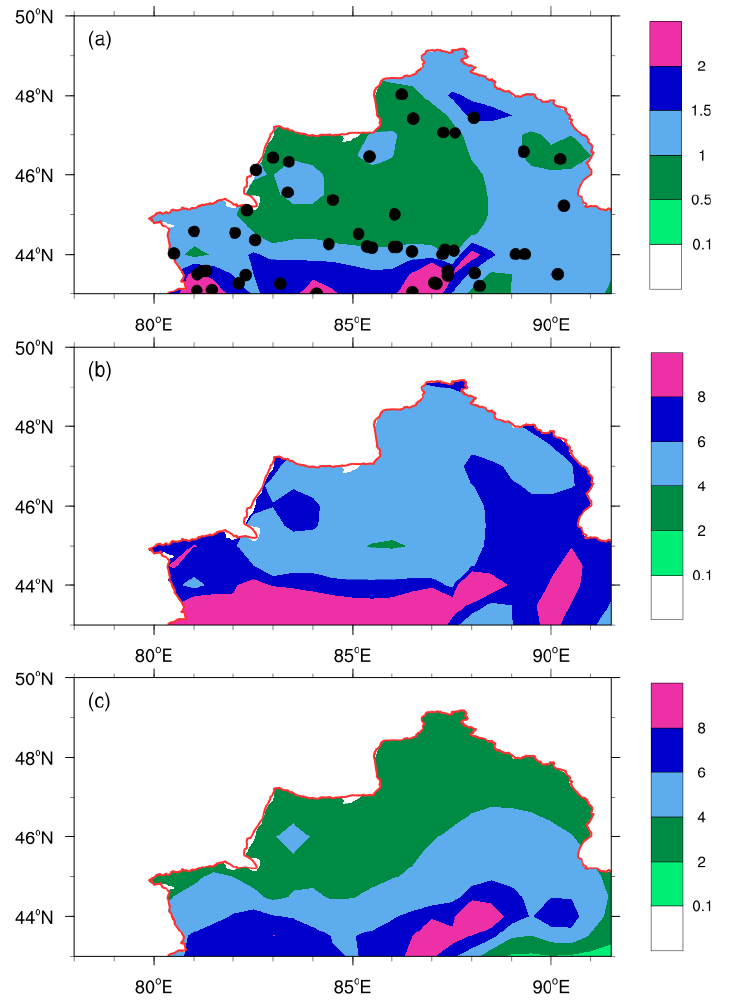
Figure 2. Precipitation in the Northern Xinjiang region in 1979–2018 (Unit: mm). ( a ) daily-averaged precipitation, with black dots indicating the locations of the observational stations; ( b ) 95th percentile of daily rainfall; ( c ) daily-averaged precipitation on extreme precipitation days.